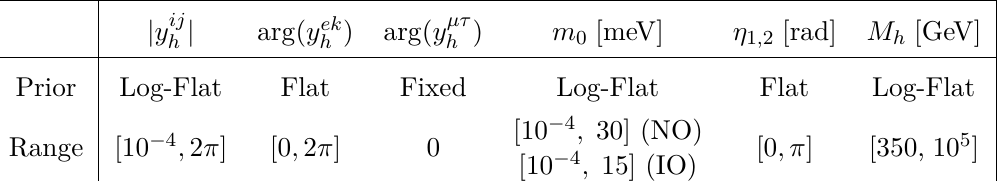
> 0 for NO, and ∆ m 2 < 0 31 32